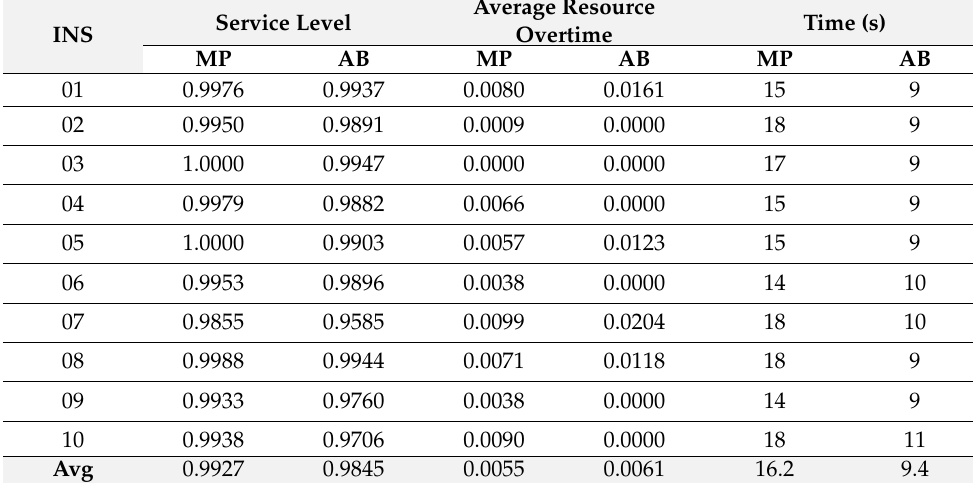
Table 2. Result of small size problem (EC PART I).